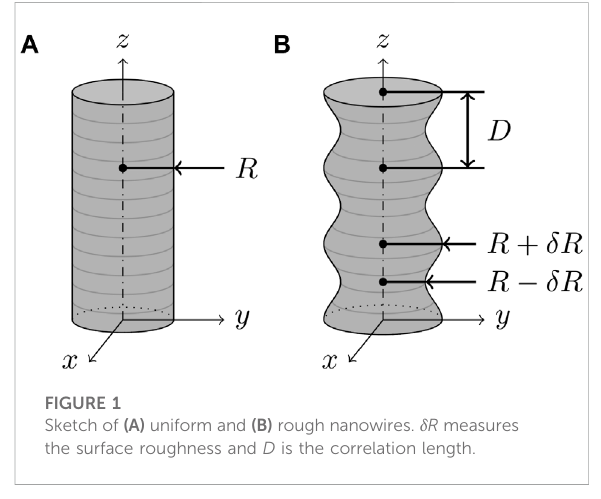
FIGURE 1 Sketch of (A) uniform and (B) rough nanowires. δ R measures the surface roughness and D is the correlation length.